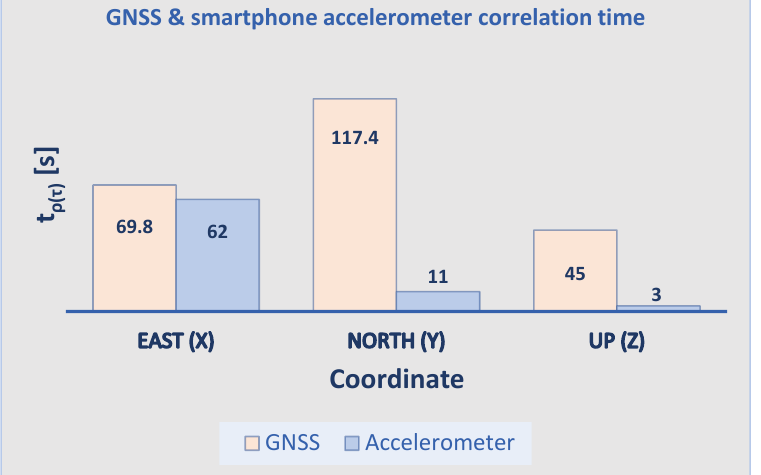
Figure 8. Comparison of correlation times in East, North and Up direction: The GNSS sensor shows an expected trace of correlation in all three components (due to LS polynomial removing and remaining MP), while the smartphone accelerometer shows mild traces of correlation; the East component is an exception to this, giving time correlation of up to 62 s for a (yet) unknown